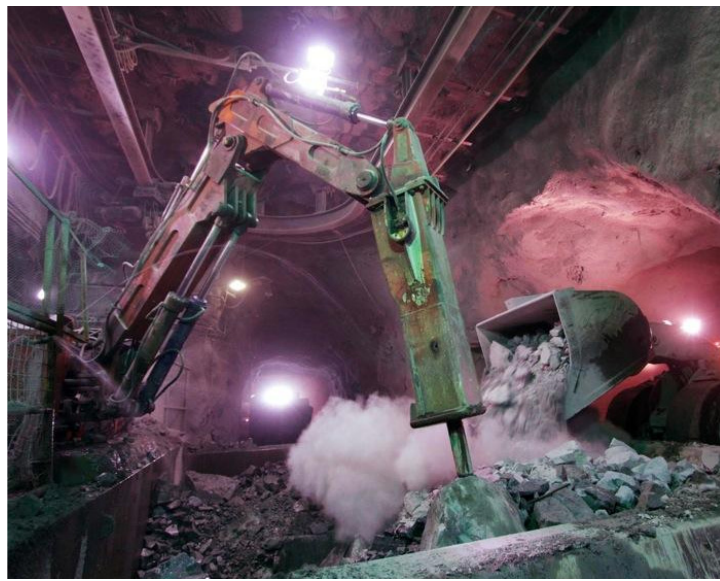
Figure 2. Real impact hammer in operation, while material is dumped onto the grizzly.